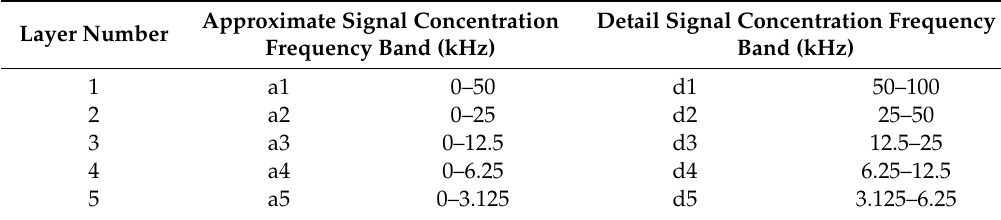
Table 1. Wavelet decomposition frequency segment.